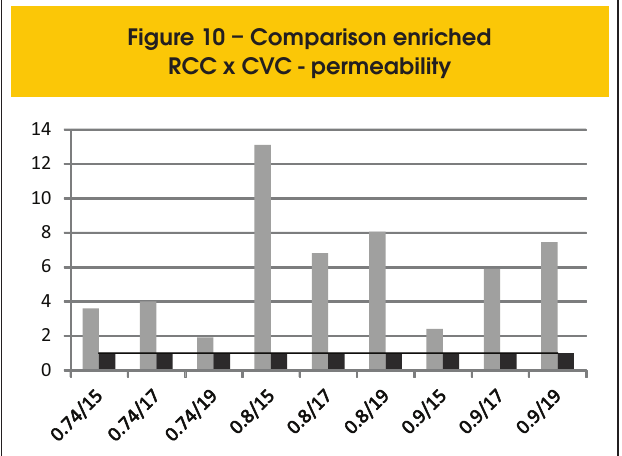
Figure 9 – Comparison enriched Figure 10 – Comparison